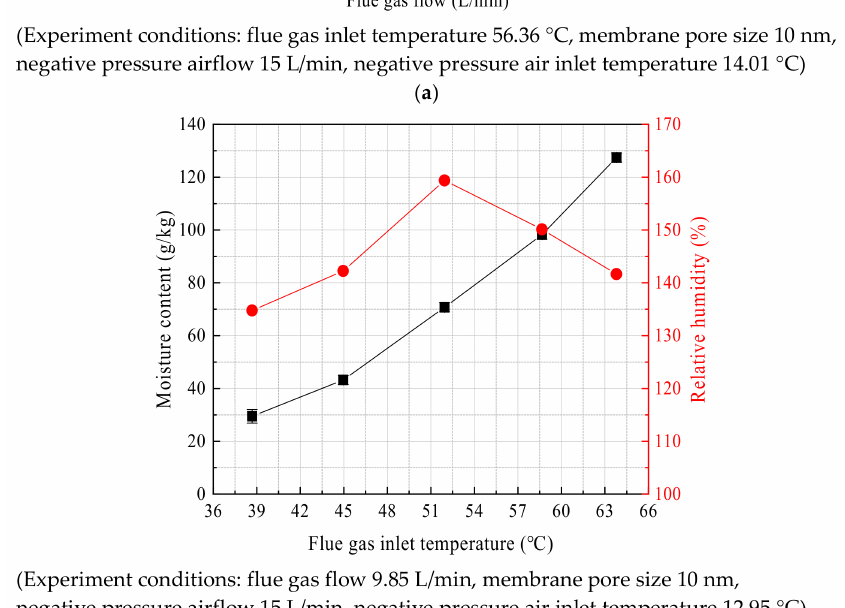
Figure 24. Humidity characteristics of the negative pressure air outlet. ( a ) Moisture content/relative humidity vs. Flue gas flow. ( b ) Moisture content/relative humidity vs. flue gas inlet